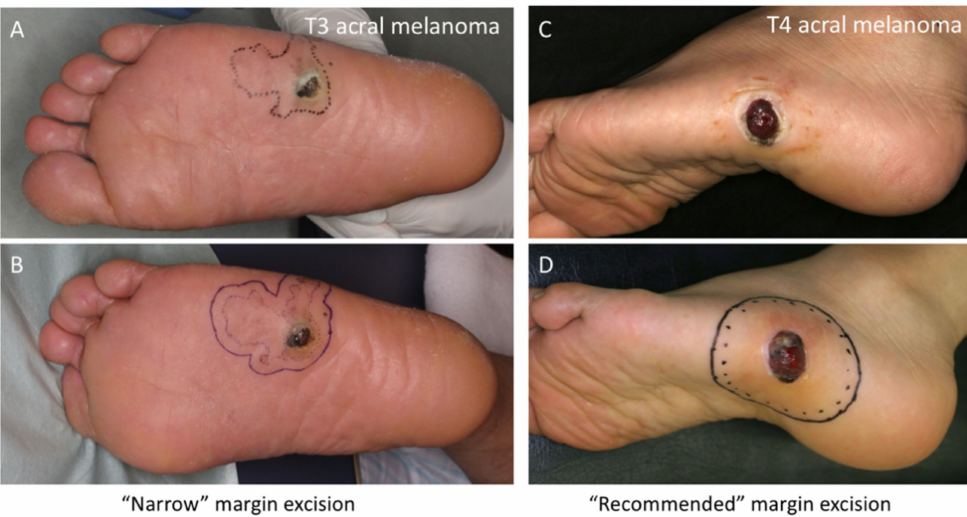
Figure 2. T3 acral melanoma with narrow excision margins on the sole ( A and B ). The dashed lines indicate the clinical tumor border. The solid resection line at the time of excision biopsy was set 0.5 cm away from the dashed line, and a final surgical margin of 1 cm was achieved at the time of reconstruction. Although the final margin was 1 cm away from the macule, it was 2 cm from the nodule. T4 acral melanoma with recommended excision margins ( C and D ). The dashed line indicates a 2-cm margin, and the solid resection line is set 2.5 cm away from the